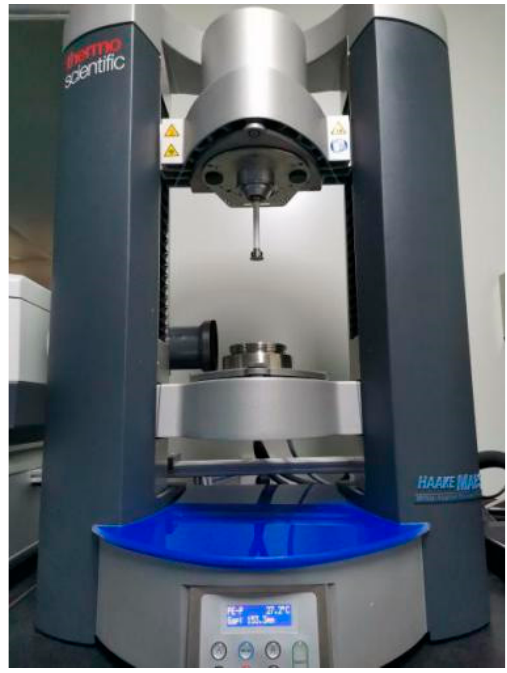
Figure 2. Rotation rheometer.